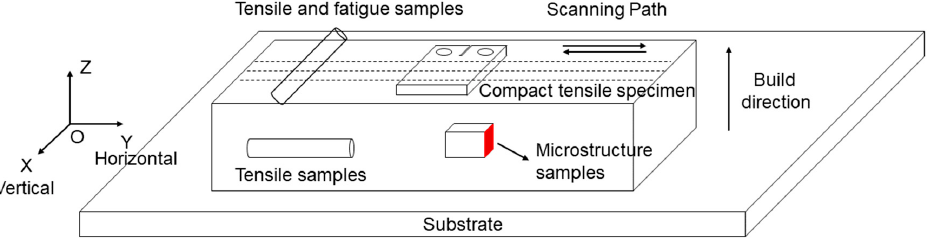
Figure 1. Sampling of multi-bead multi-layer blocks.